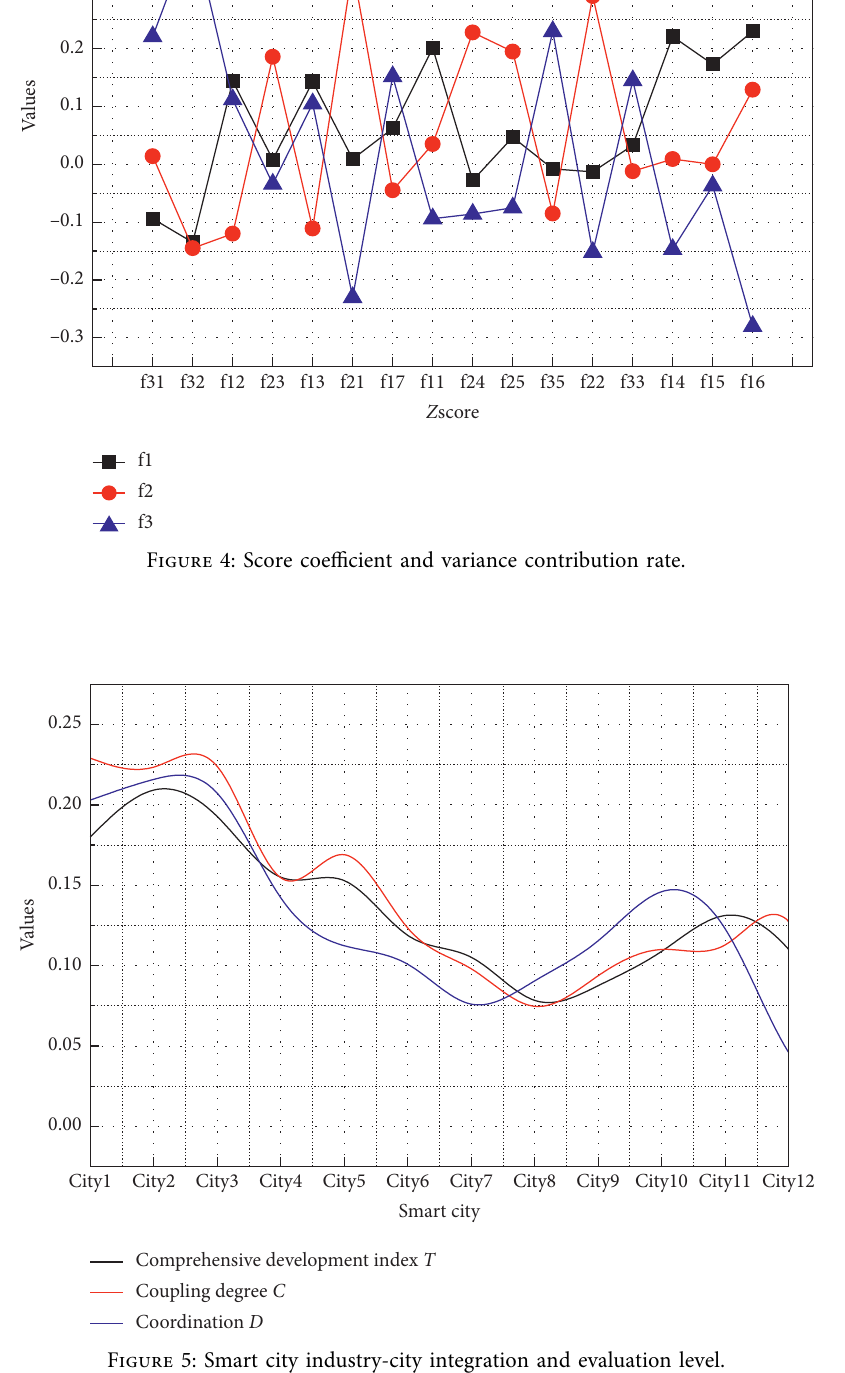
Figure 5: Smart city industry-city integration and evaluation level.